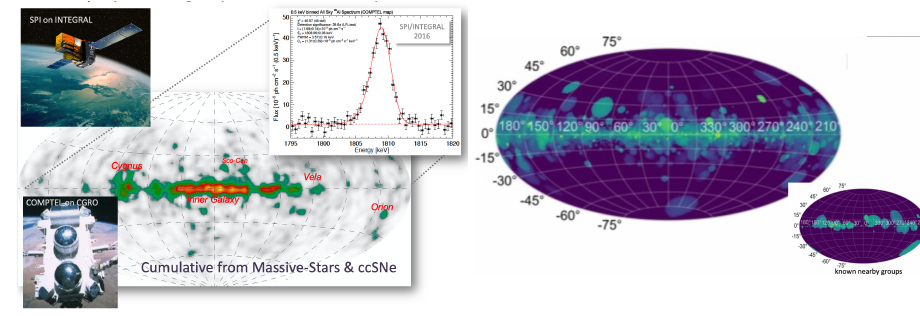
Figure 5. Left: The 26 Al decay in the Galaxy has been imaged across the sky with data from COMP- TEL; high-resolution spectroscopy was added with measurements from INTEGRAL . Right: A bottom- up model, based on known massive-star cluster locations nearby and MC-sampled clusters at large dis- tances, and using stellar and supernova yields and line-of-sight integrated intensities, predicts an 26 Al appearance of the sky that is close to observations. The inset at the bottom right shows the contributions from known nearby clusters alone. [From